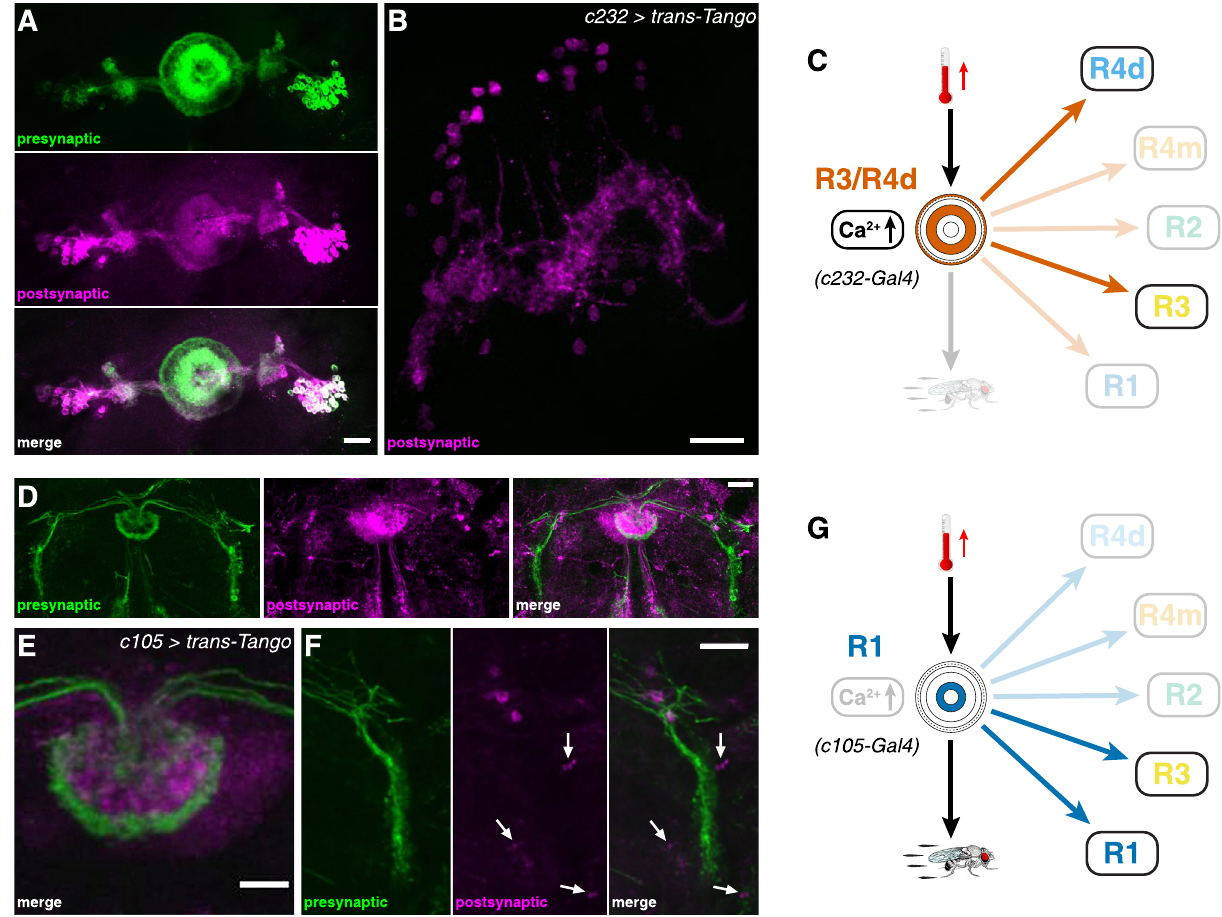
Figure 7. Segregated connectivity and function of R3/R4d and R1 ring neurons in thermoresponsive motor behavior. ( A , B ) trans -Tango based anterograde transsynaptic tracing of c232-targeted R3/R4d ring neurons indicates reciprocal connections onto themselves and connections to ( B ) columnar wedge neurons but not directly to other rings. ( A ) Detail of presynaptic signal (left top, green), postsynaptic targets (left middle, magenta) and merged image (left bottom) of EB cell bodies and ring neuropil, as well as the bulb. ( C ) R3/ R4d ring neurons only connect to themselves; they integrate temperature increase but do not mediate thermoresponsive motor behavior. ( D–F ) c105-targeted trans -Tango labelling identifies presynaptic R1 and R3 layers of the EB ring neuropil, as well as the LAL (left, green). Postsynaptic targets (middle, magenta) include R1 and some parts of R3 as seen in the merged image (right), ( E ) detail of the ring structure in a different brain (merged image shown) and ( F ) detail of the LAL connections (arrows). ( G ) R1 ring neurons connect to themselves and R3; they do not integrate temperature increase but mediate thermoresponsive motor behavior. Scale bars, 20